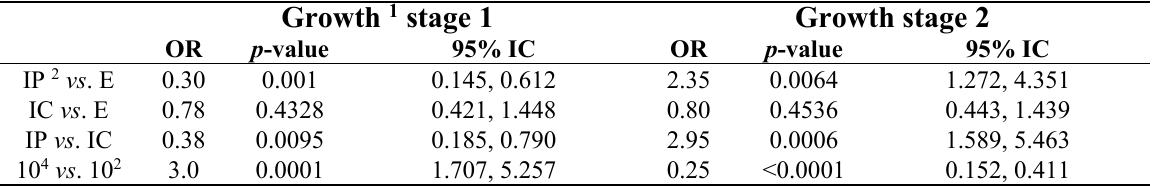
Table 2. Odds ratio estimated by logistic regression of proportion of P. radiata damaged germlings on inoculation method and inoculum